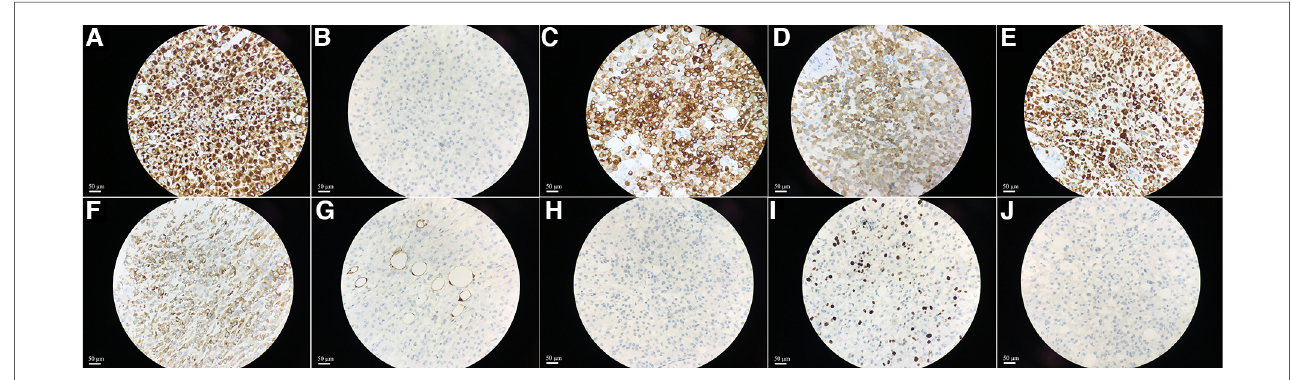
FIGURE 3 The immunohistochemical staining showed the expression of Vimentin, NSE, Syn, Inhibin, Melan A, calretinin, S-100, Desmin, Ki67 and Alk in tissues, original ampli fi cation ×400 ( A – J